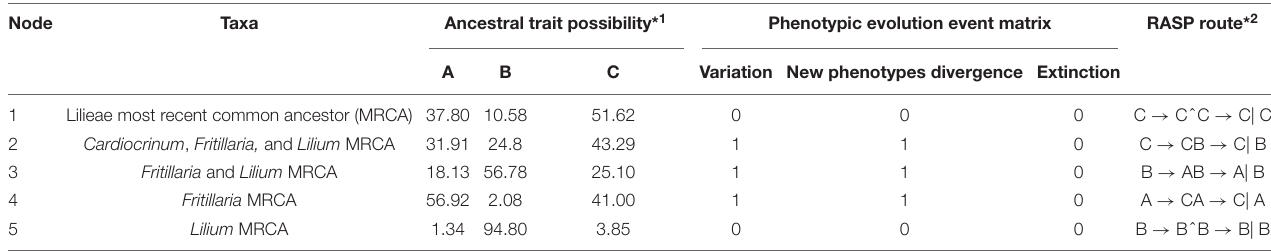
TABLE 2 | Bulb ancestral trait transitions across Lilieae (see Figure 4 ).